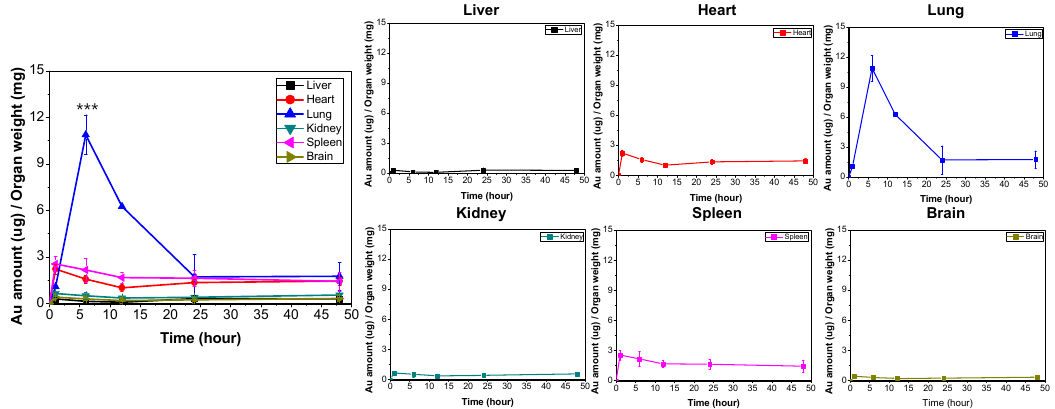
Figure 4. Quantification analysis of Au ion accumulation in the major organs (liver, heart, lungs, kidneys, spleen, and brain) obtained by ICP-MS. Each organ was collected at 1, 6, 12, 24, and 48 h after intravascular injection (N = 6). (statistical analysis mark means *** P<0.05).